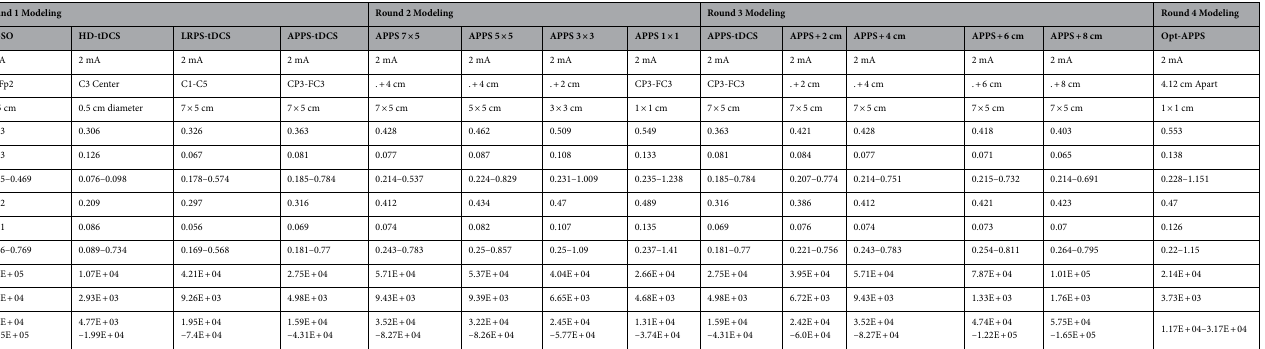
Table 2. Means, Standard Deviations, and Ranges of E-Field Magnitudes and Focality in Rounds 1–4 Modeling.